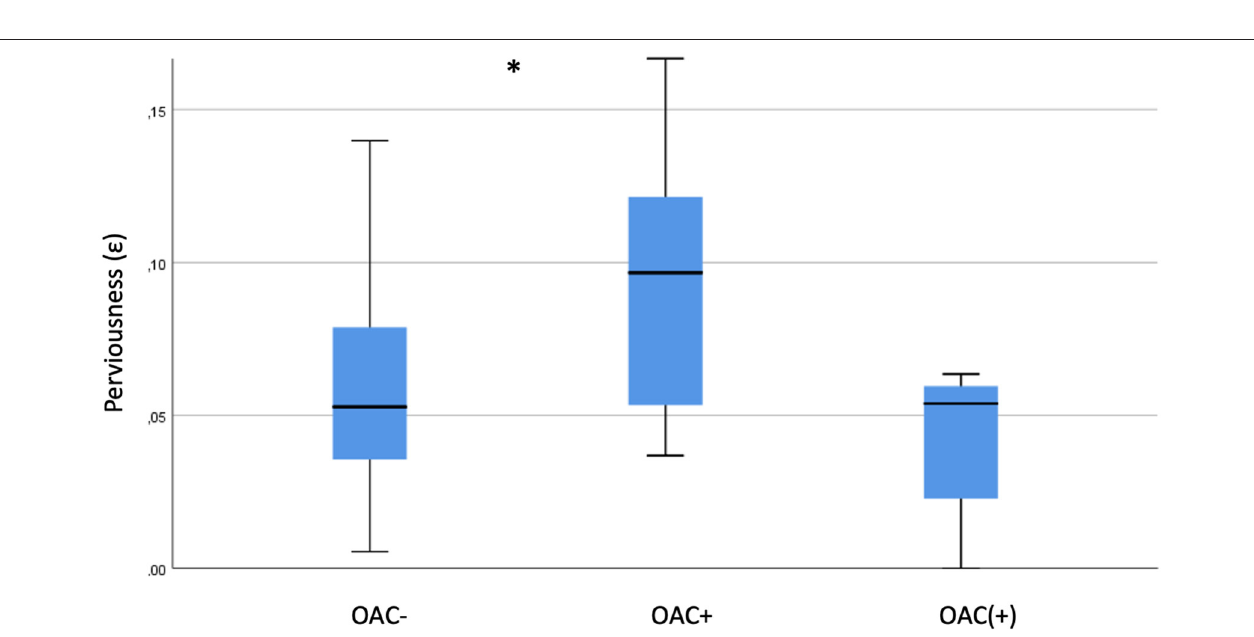
FIGURE 4 | Perviousness of thrombi with prior insufficient anticoagulation. Comparison of thrombi without (OAC–), with (OAC + ) and with insufficient [OAC( + )] prior anticoagulation. * indicates p < 0.05.